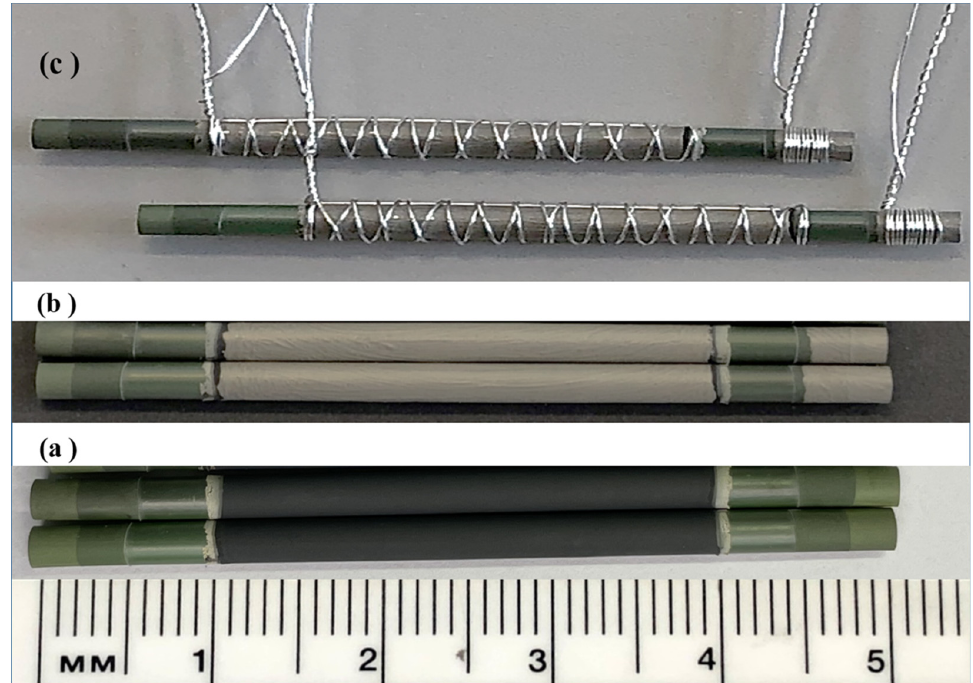
Figure 2. Photograph of MT-SOCs prepared by dip-coating: ( a ) completed MT-SOCs ( b ) completed MT-SOCs with silver current collection layer, ( c ) completed MT-SOCs having silver wires wrapped around silver current collection layer.